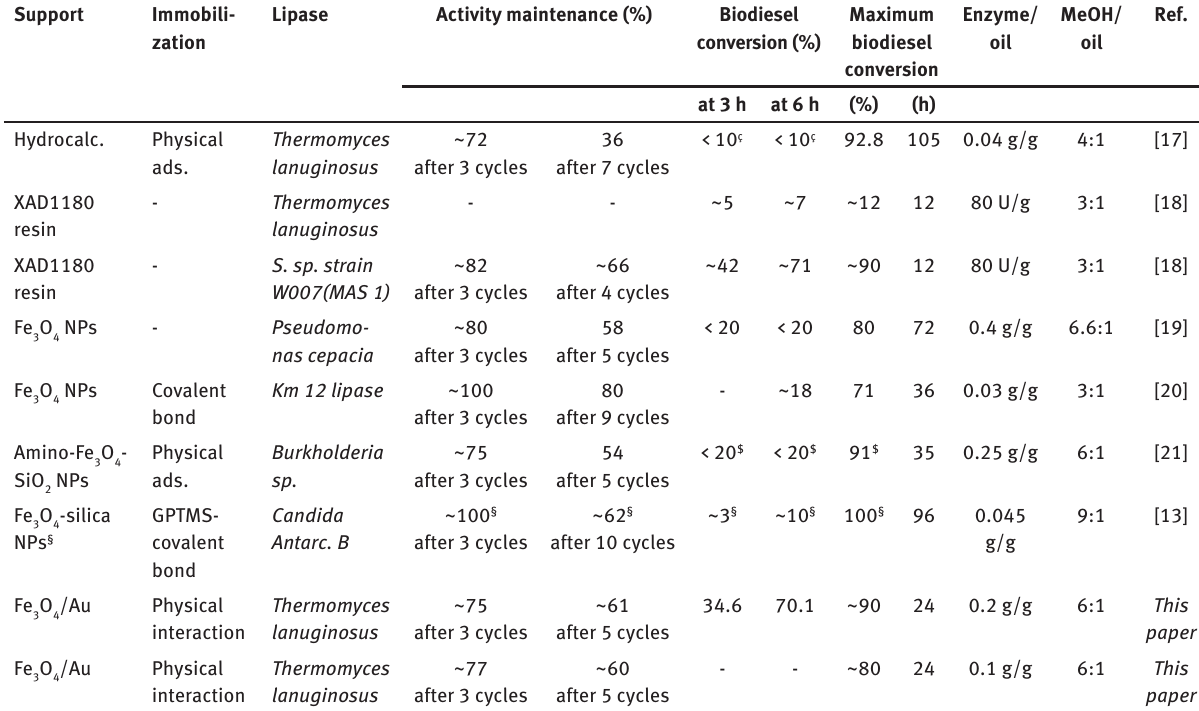
Table 2: Comparison of the catalytic abilities of different enzymes for biodiesel production from WCOs. Support